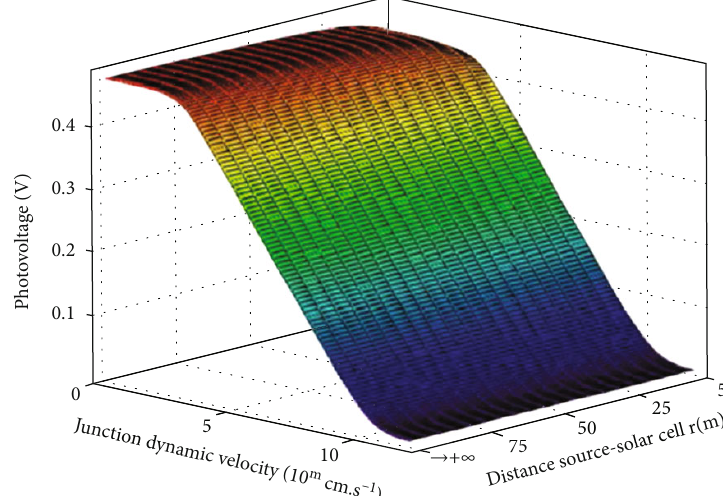
= 0 : 015cm, D = 26 cm 2 · s − 1 , μ n n